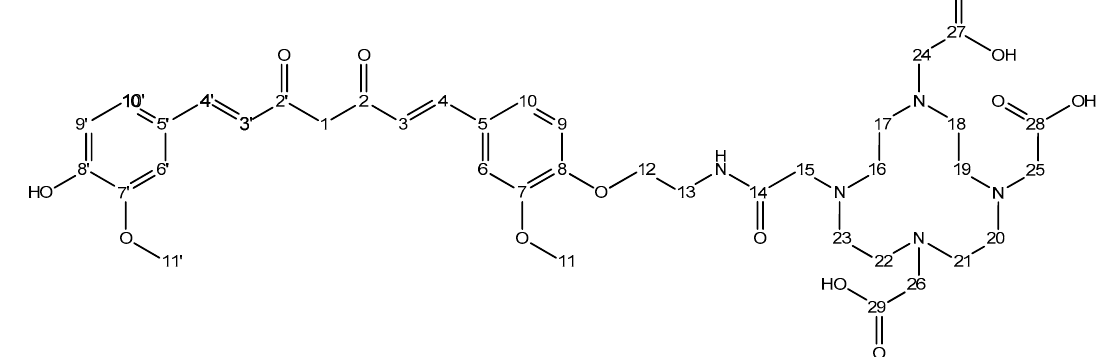
Figure 11. Chemical structure of DOTA-C21 with atom numbering.